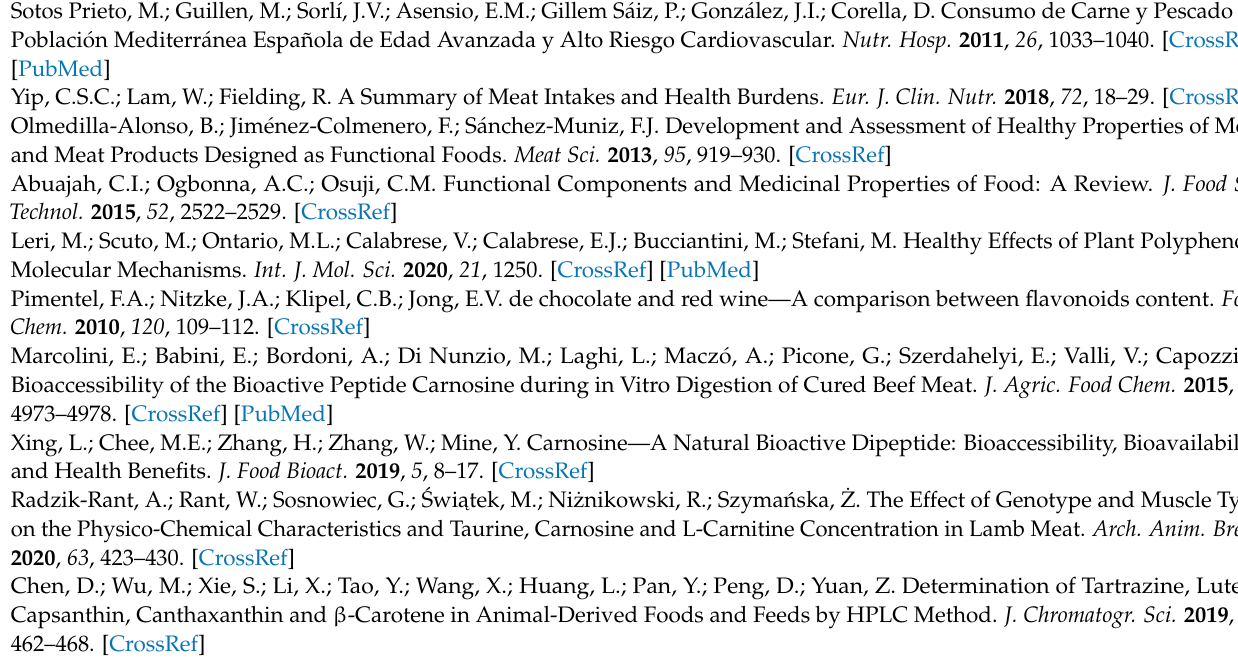
Table S2. Antioxidant capacity of in vitro digested-fermented foods of animal origin depending on the cooking method. Supplemental Table S3. Antioxidant capacity of in vitro digested-fermented foods of animal origin depending on the group. Supplemental Table S4. Antioxidant capacity of in vitro digested-fermented dairy foods depending on the cooking method. Supplemental Table S5. Antioxidant capacity of in vitro digested-fermented dairy foods depending on the dairy type. Supplemental Table S6. Antioxidant capacity of in vitro digested-fermented fish depending on the cooking method. Supplemental Table S7. Antioxidant capacity of in vitro digested-fermented fish depending on the fish type. Supplemental Table S8. Antioxidant capacity of in vitro digested- fermented meat depending on the cooking method. Supplemental Table S9. Antioxidant capacity of in vitro digested-fermented meat depending on the meat type. Supplemental Table S10. Antioxidant capacity of in vitro digested-fermented red and white